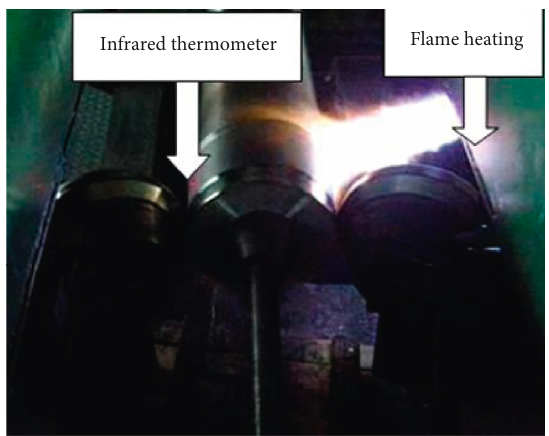
Figure 17: Temperature control and heating during